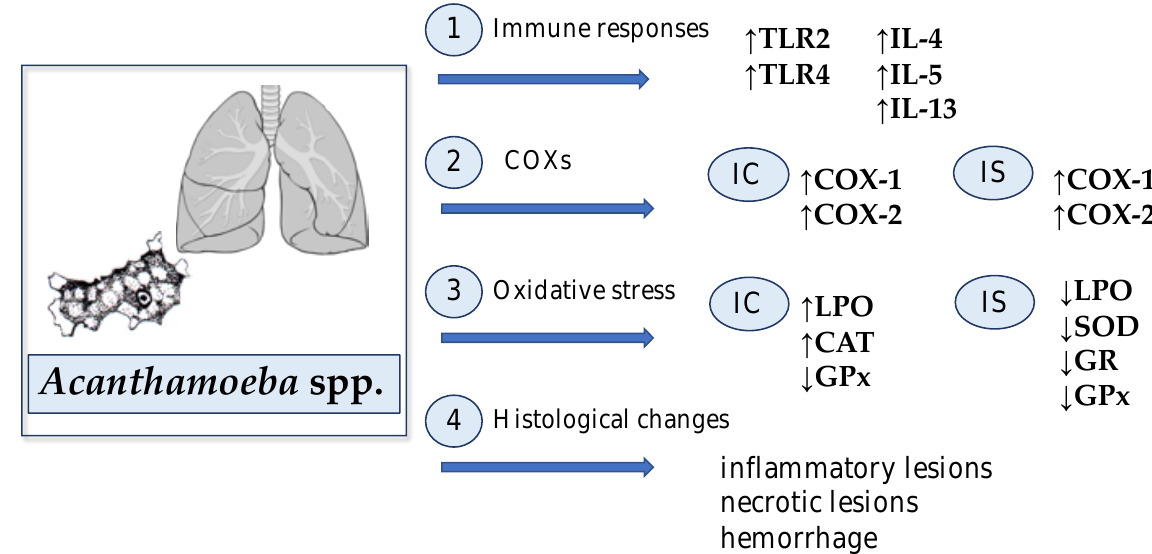
Figure 2. Host defense mechanisms against Acanthamoeba spp. infection in the lungs: 1. Acanthamoeba spp. infection affects the growth of Toll-like receptor (TLR) expression, mainly TLR2 and TLR4. Moreover, it was found that Acanthamoeba spp. increased the synthesis of Th2 cytokines, such as interleukin (IL)-4, IL-5, and IL-13; 2. Acanthamoebiasis causes an increase in expression of cyclooxygenase-1 (COX-1) and -2 (COX-2) in immunocompetent (IC) and immunosuppressed (IS) hosts; 3. Acanthamoeba spp. infection causes oxidative stress manifested by an increase in lipid peroxidation (LPO) and changes in antioxidant enzyme activity in the immunocompetent hosts; an increase in catalase (CAT) and a decrease in glutathione peroxidase (GPx). In immunosuppressed hosts, Acanthamoeba spp. causes a decrease in LPO and a decrease in superoxide dismutase (SOD), glutathione reductase (GR) and GPx; 4. The amoebas induced hemorrhage, inflammatory and necrotic lesions in the lungs.